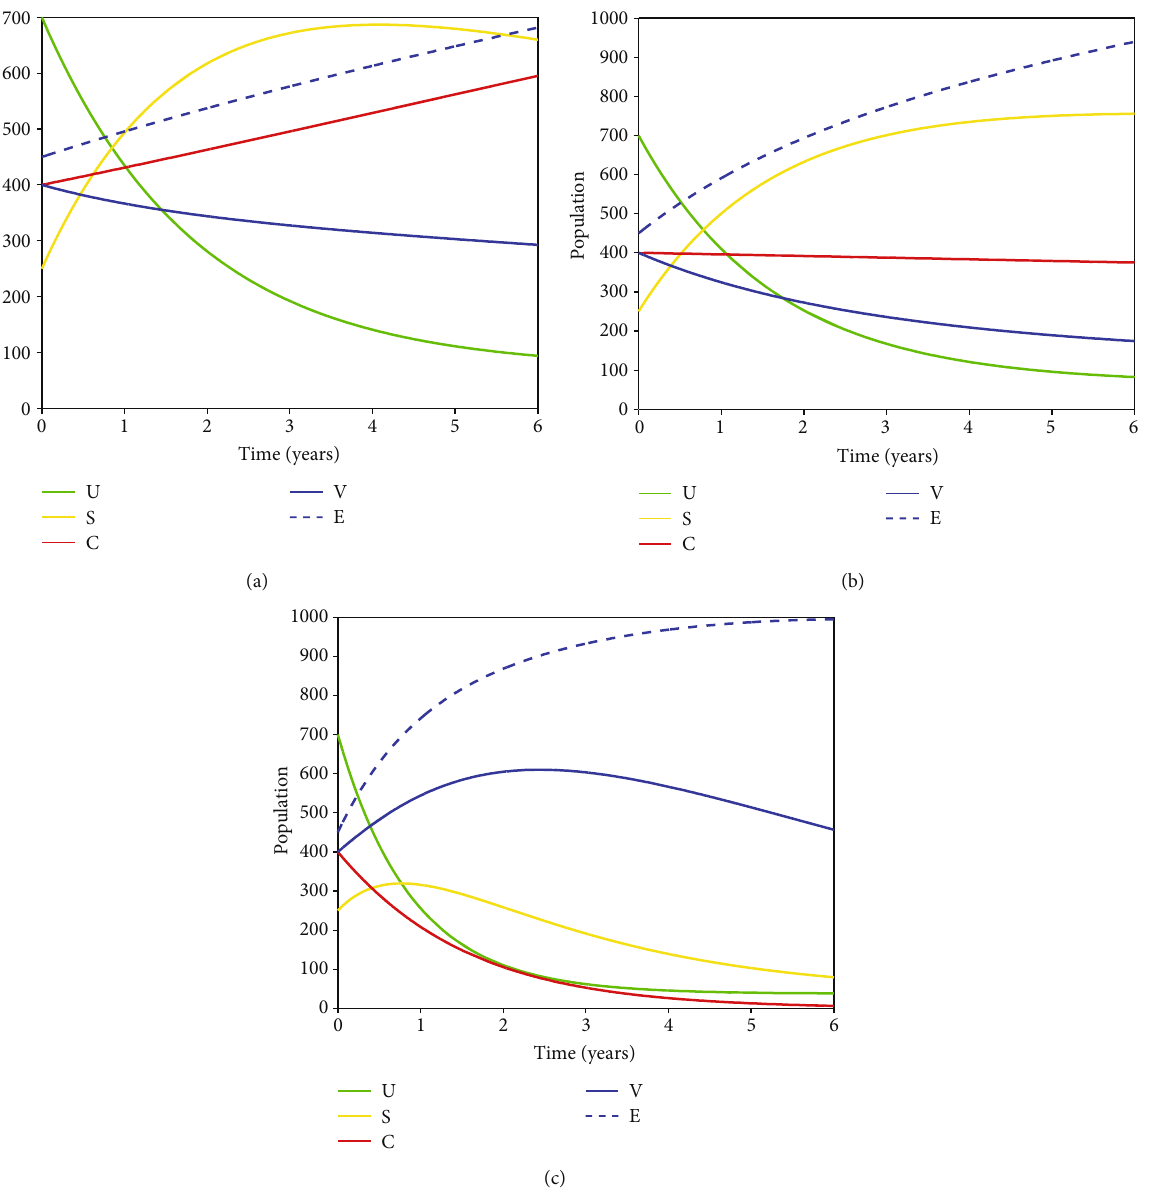
= 1 : 4045 . (b) Simulation result showing the population when R 0